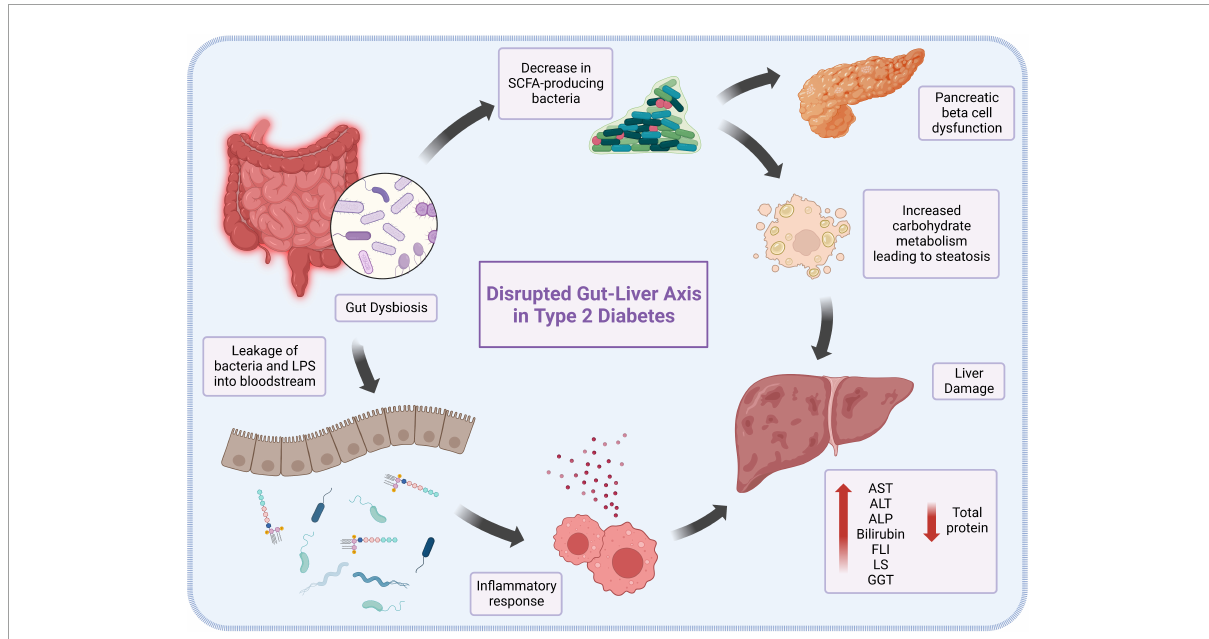
FIGURE1 The role of gut dysbiosis in the pathogenesis and progression of type 2 diabetes-induced liver